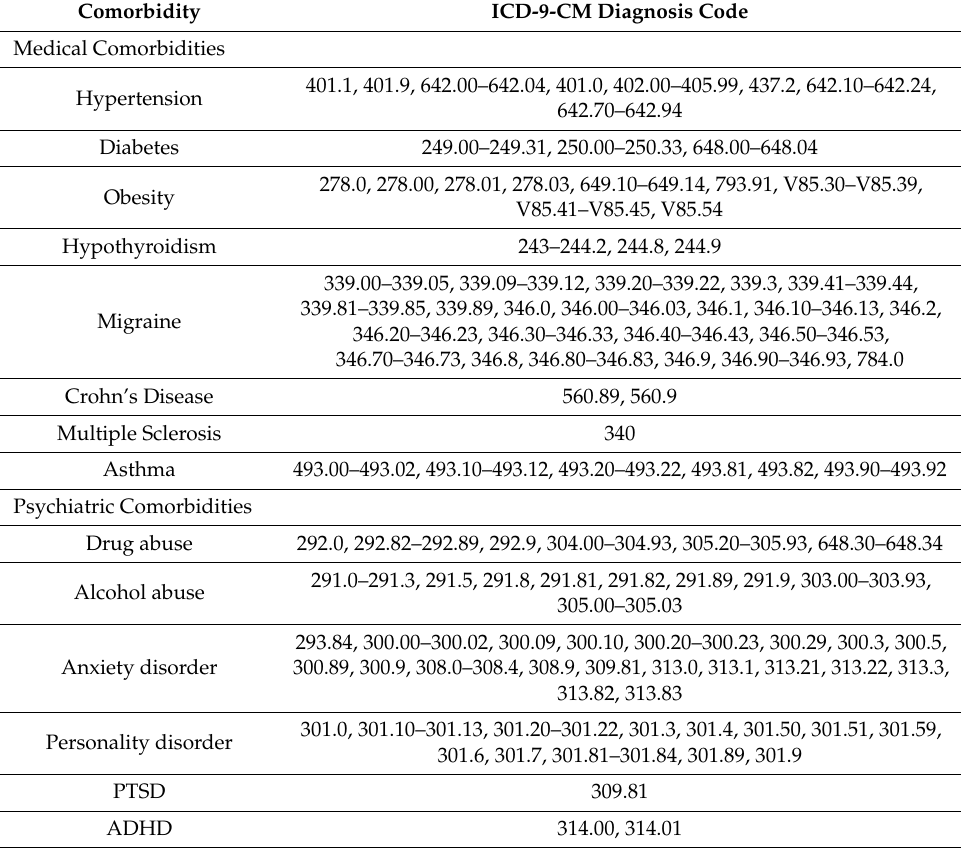
Table 1. International Classification of Disease, Ninth Clinical Modification (ICD-9-CM) codes used to identify comorbidities in patients with bipolar